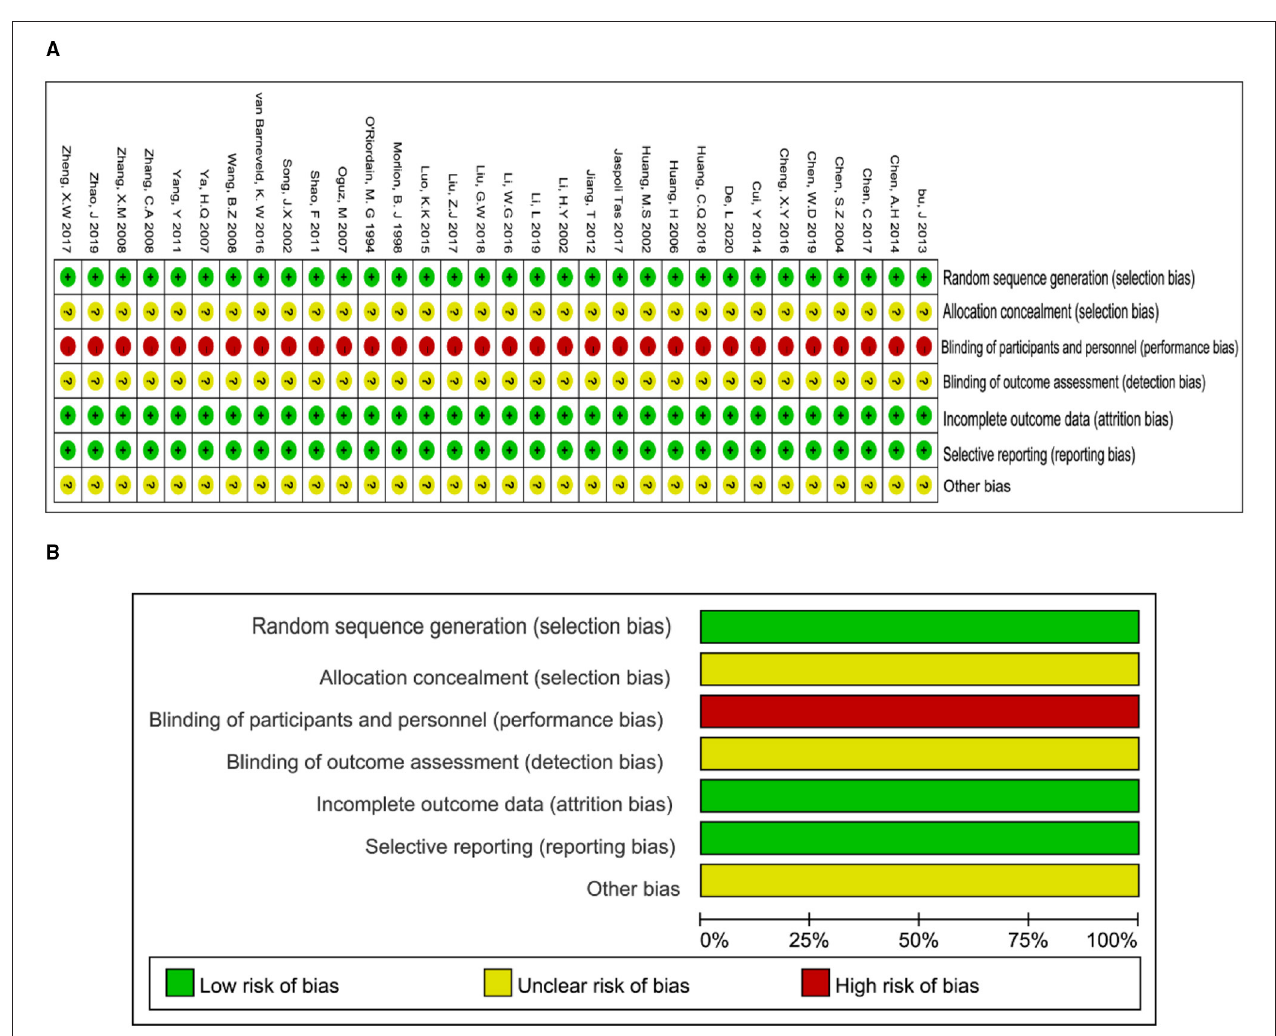
FIGURE 2 | Methodological quality graph and summary of the included studies: (A) Risk of bias summary; (B) Risk of bias